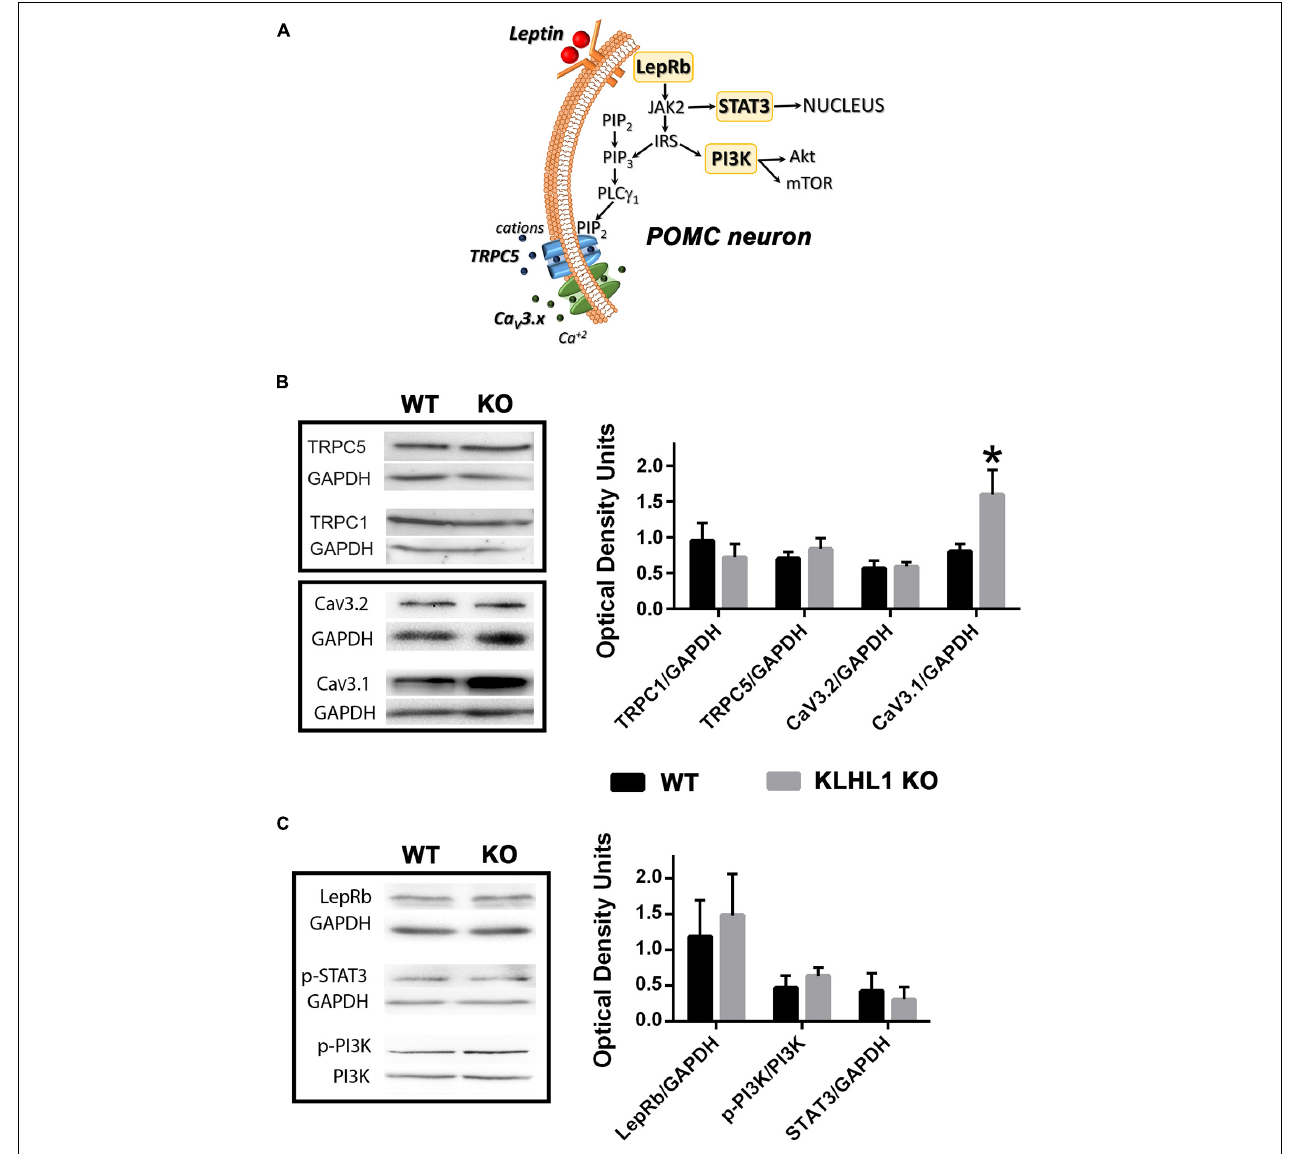
FIGURE 1 | Overexpression of Ca V 3.1 T-type calcium channels in KLHL1-KO mice hypothalamus. (A) Pleiotropic signaling of leptin in POMC hypothalamic neurons. Leptin binding to its receptor LRb results in the downstream activation of JAK2. STAT3 is subsequently phosphorylated and mobilized to the nucleus resulting in de novo gene expression. Activation of insulin receptor substrate (IRS) stimulates Akt- and mTOR pathways via activation of phosphorylated PI3K and the production of PIP3. The activation of PLC λ 1 by PIP3 mediates the activation of TRPC1/5 channels, recruiting T-type CaV3.1/2 channels thought membrane